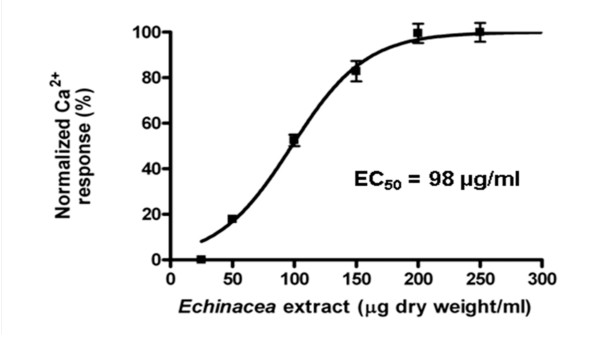
Dose-response curve of the transient increase in cytosolic Ca2+ concentration in HEK293 cells evoked by E. purpurea root ethanol extracts. Results are expressed as percentages of maximum responses. Each data point represents mean ± SEM, n = 3 replicates. EC50 = 98 ± 7 μg/ml. The response saturates at 200 μg/ml of extract. The Hill equation was used to fit the response curve.